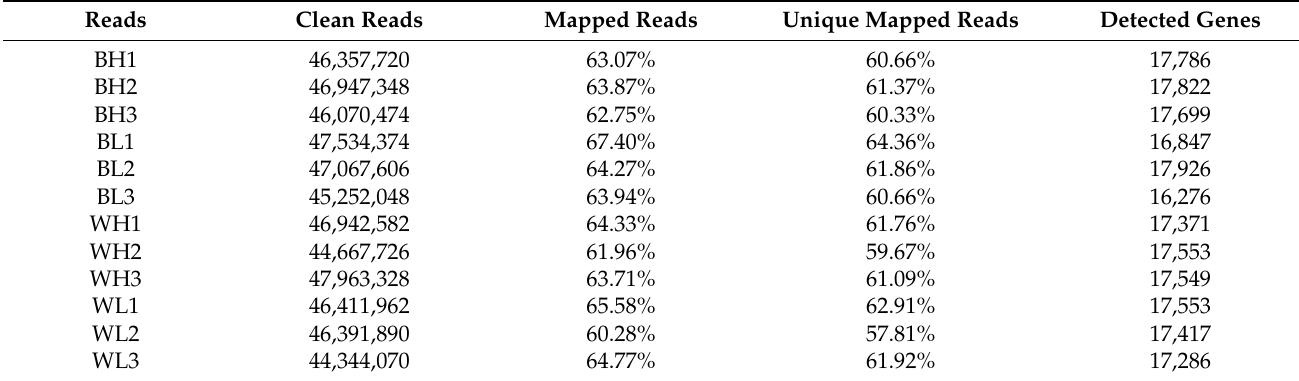
Table 3. Summary of reads and matches.